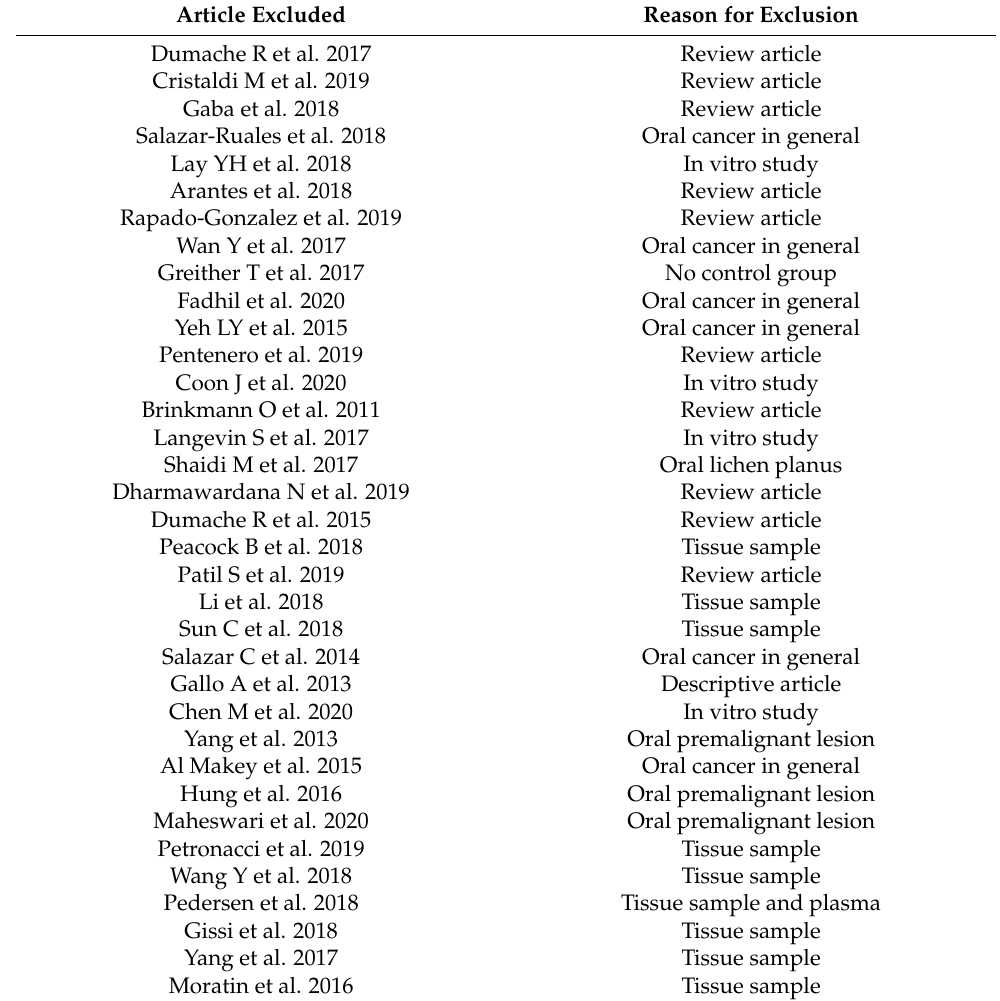
Table A1. Table reporting the 35 excluded studies and reasons for